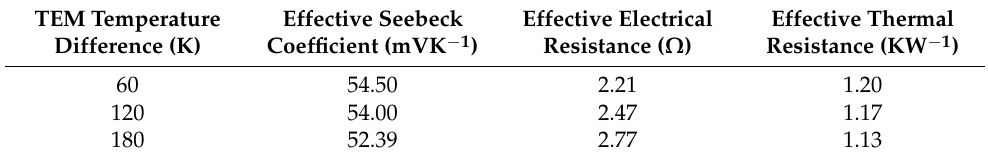
Table 1. TEM effective thermoelectric properties (Marlow TG12-8-01LS).